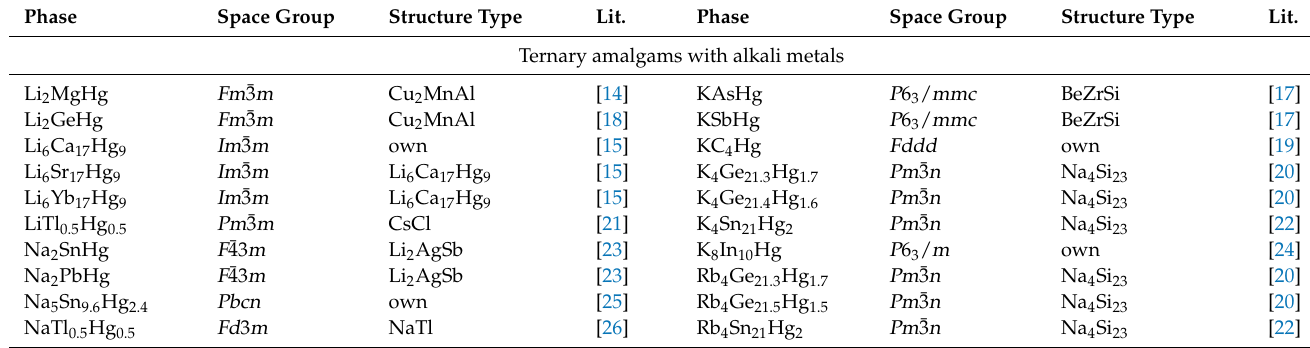
Table 1. Ternary amalgams described in the literature containing at least one less noble (=alkali, alkaline earth, or lanthanoid) metal. Data are compiled from Pearson’s Crystal Data